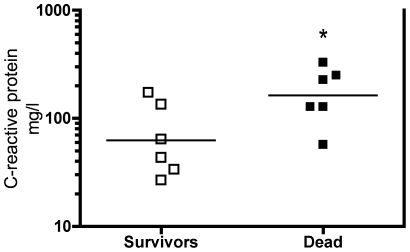
Higher plasma C-reactive protein levels in non-surviving than in surviving ICU patients.Data are fold change in individual values. Each square represents one patient (white: survivors, black: dead) and the bar represents the mean value. * p<0.05.